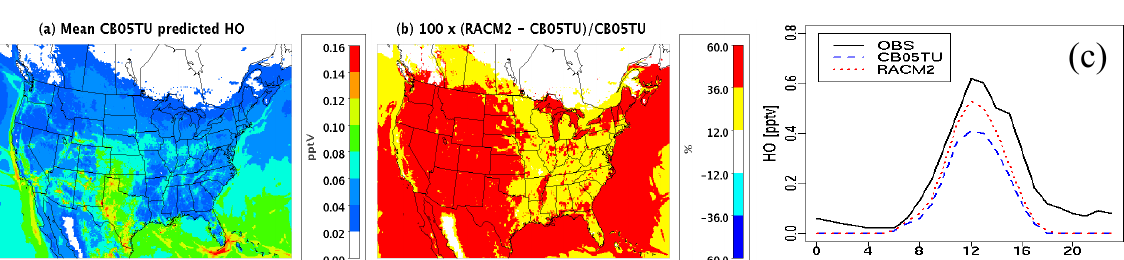
Figure 1: (a) Predicted mean HO obtained with CB05TU (b) percent differences in mean HO between RACM2 and CB05TU (c) a comparison of predicted median HO to observed median data from the 2006 Texas Air Quality Study.